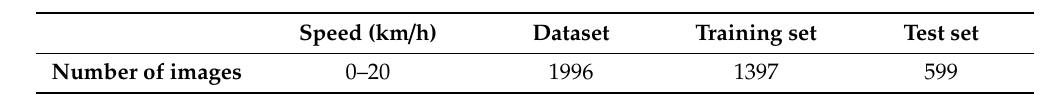
Table 10. Dataset of the Q-SPC